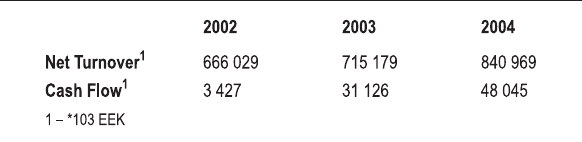
Fig. 3. The consolidated turnover and cash fl ow of